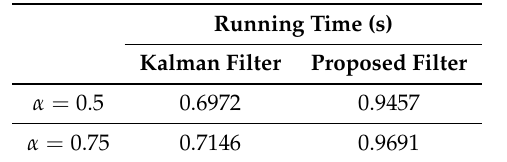
Table 2. Comparisons of the running times.